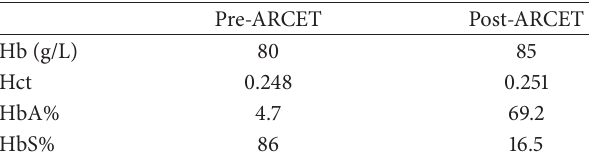
Table 2: Haematological values before and after exchange transfu-